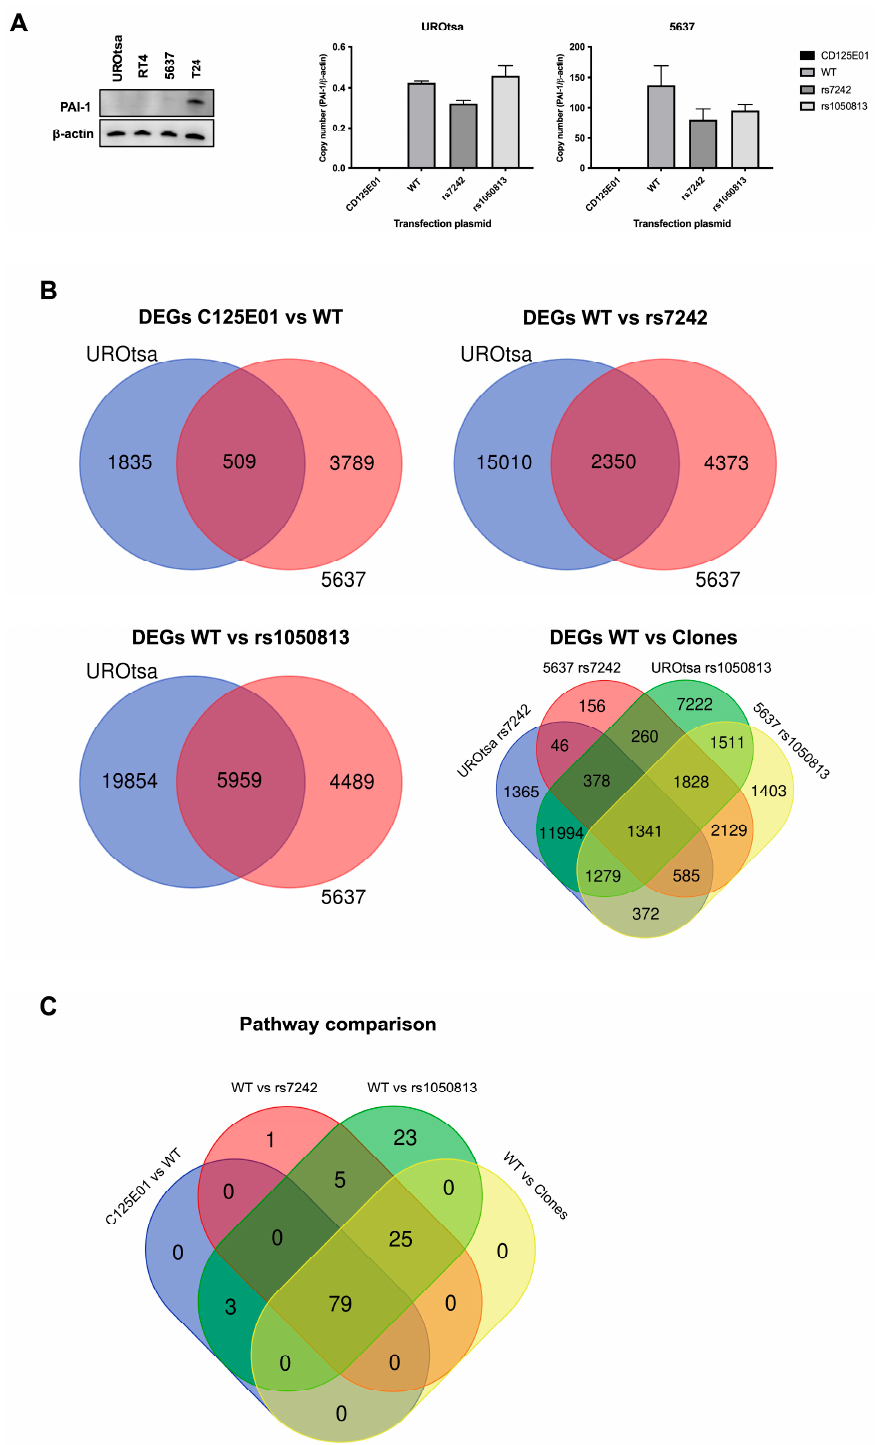
Figure 2. The effects of PAI1 SNPs in its downstream pathways. ( A ) PAI1 protein expression in urothelial cell lines. Plasmids for C125E01, PAI1 WT, PAI1 rs7242, and PAI1 rs1050813 were transiently transfected into UROtsa and 5637 cells which show no or low PAI1 expression. ( B ) Venn diagram showing the overlapping genes in DEGs C125E01 vs. WT, DEGs WT vs. rs7242, DEGs WT vs. rs1050813, and DEGs WT vs. both clones between UROtsa and 5637 cells. ( C ) Venn diagram representing the overlap of pathways identified based on the overlapping genes in Figure 2B.